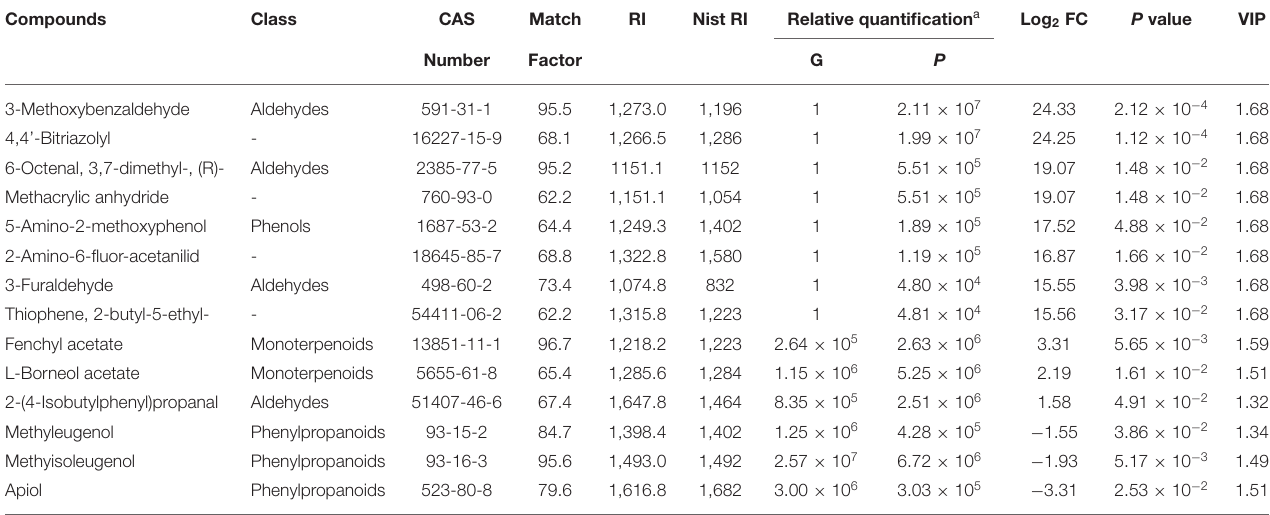
TABLE 3 | Differentially accumulated volatile metabolites in leaves of the different fennel varieties analyzed by GC-MS ( n = 3). Compounds Class CAS Match RI Nist